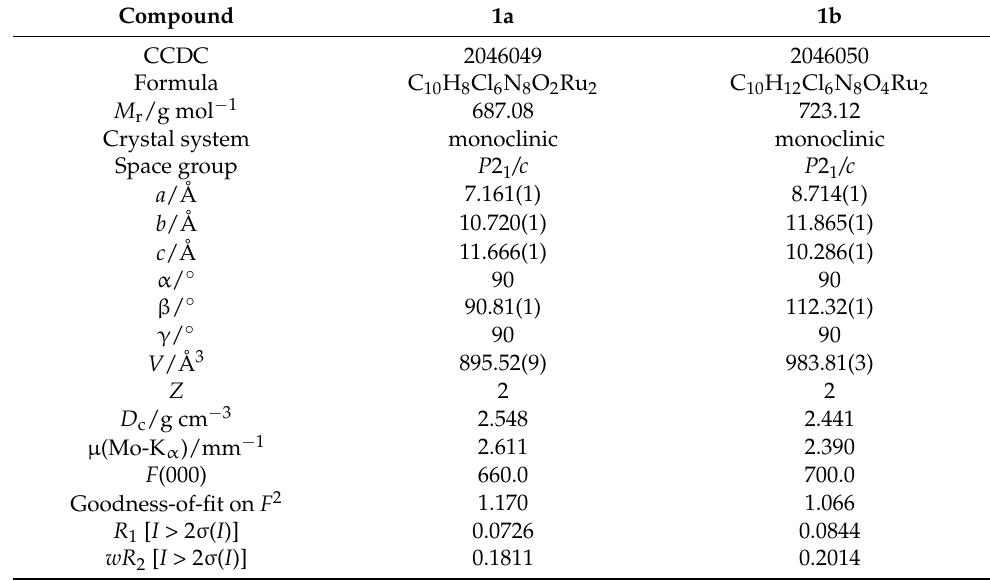
Table 1. Summary of the crystal data and structure refinement parameters for 1a and 1b